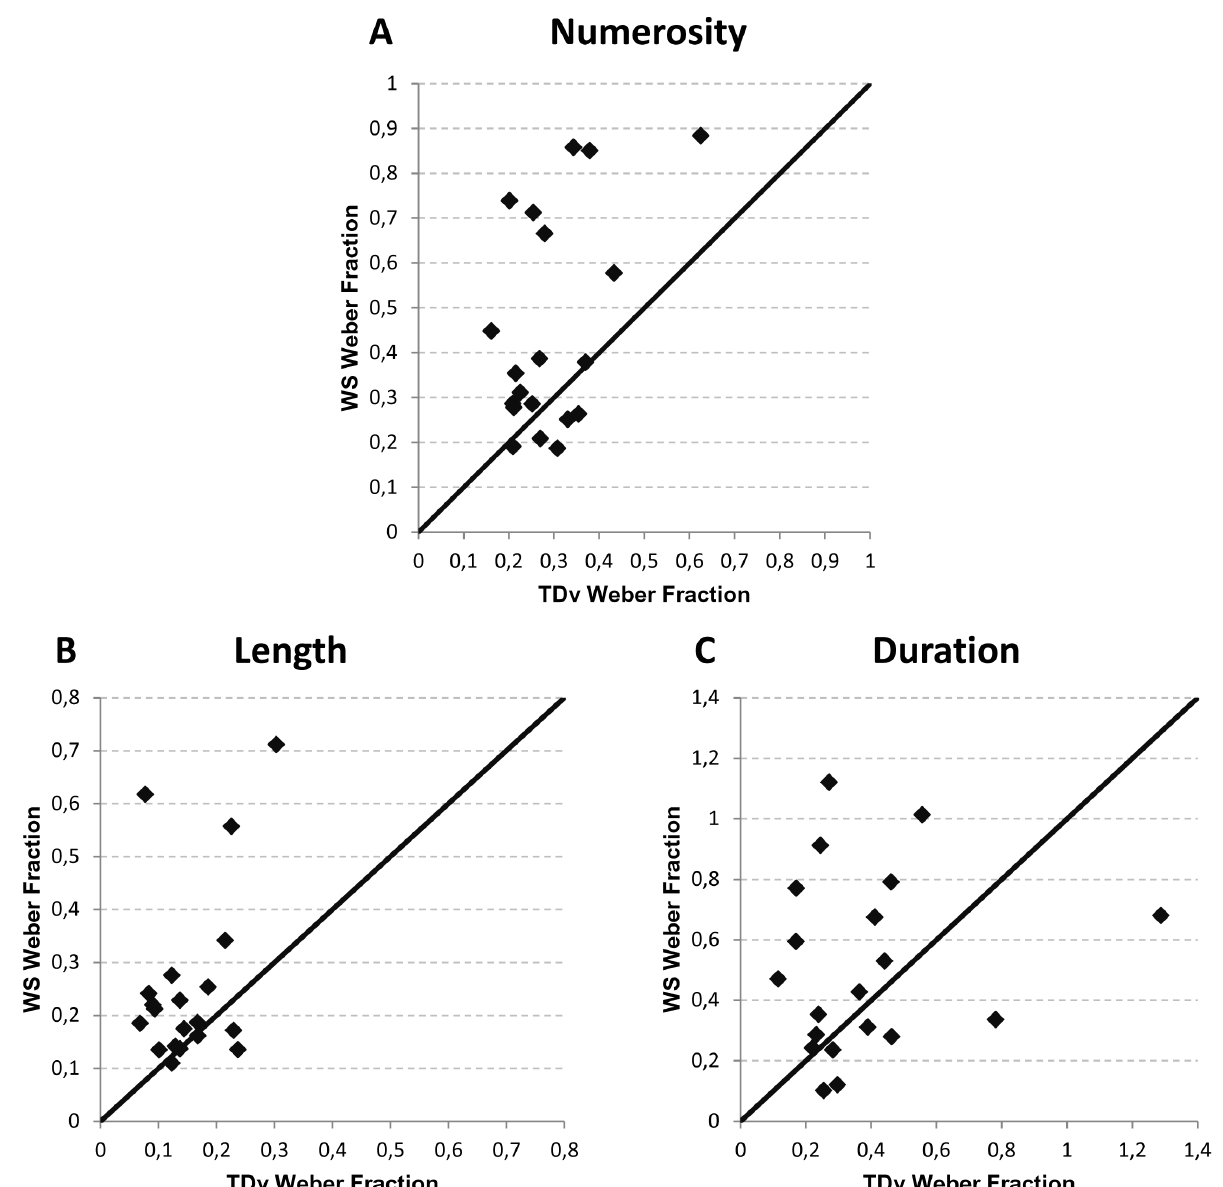
Figure 3. Within-pair Weber fraction associations. Each panel shows the correspondence between Weber fractions within each WS-TDv pair of participants in the numerical (A), spatial (B) and temporal (C) comparison tasks,